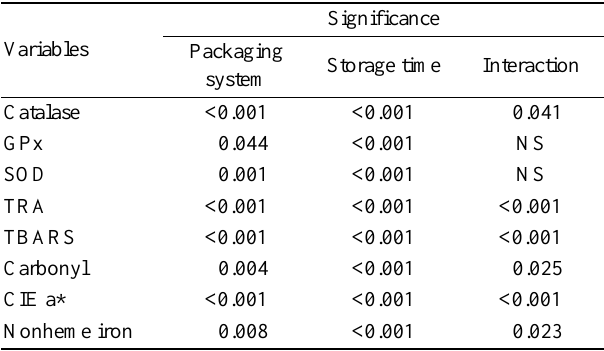
Table 1. Effects of packaging system, storage time, and their interaction on the variables